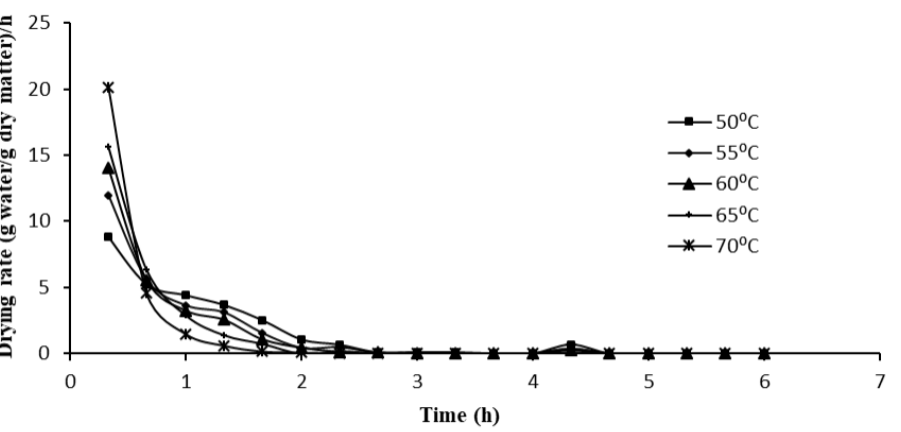
Figure 2. Changes in drying rate with drying time at different air temperatures for wheatgrass.